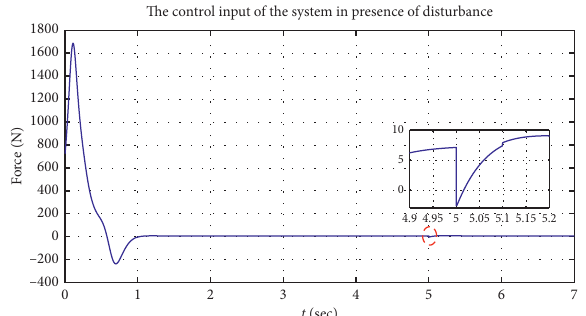
Figure 3: Evolution of the control signal F ( t ) .